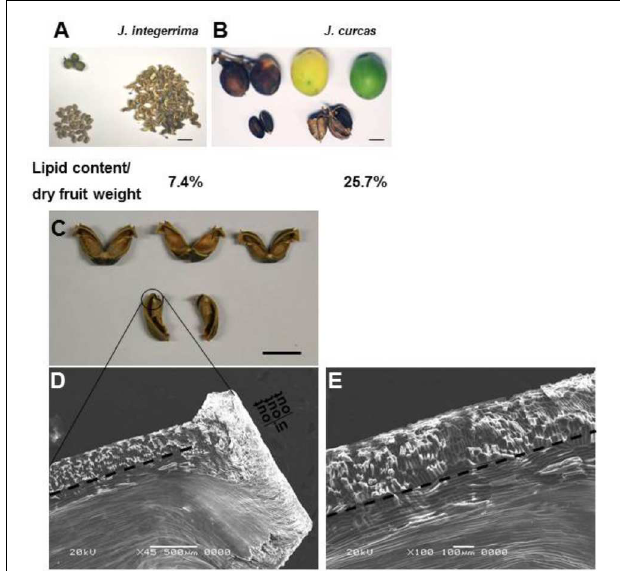
FIGURE 2 | Comparisons of seeds and fruits size, lipid content in dry fruit weight of J. integerrima and J. curcas . (A,B) Fruits size, seeds size, fruits shell, and dry fruit lipid content of J. integerrima ( Ji ) and J. curcas ( Jc ), respectively. Noted that fiber-rich husk is the major constituents in fruits of J. integerrima. Values are mean ± SD ( n = 3, total lipid weight against dry fruit weight). Bar: 20 mm. (C) Twisted J. integerrima fruit shell after drying. Bar: 10 mm. (D,E) Different magnification of SEM observation of twisted J. integerrima fruit shell. Bar of Figures 2D,E was 500 and 100 µ m, respectively.